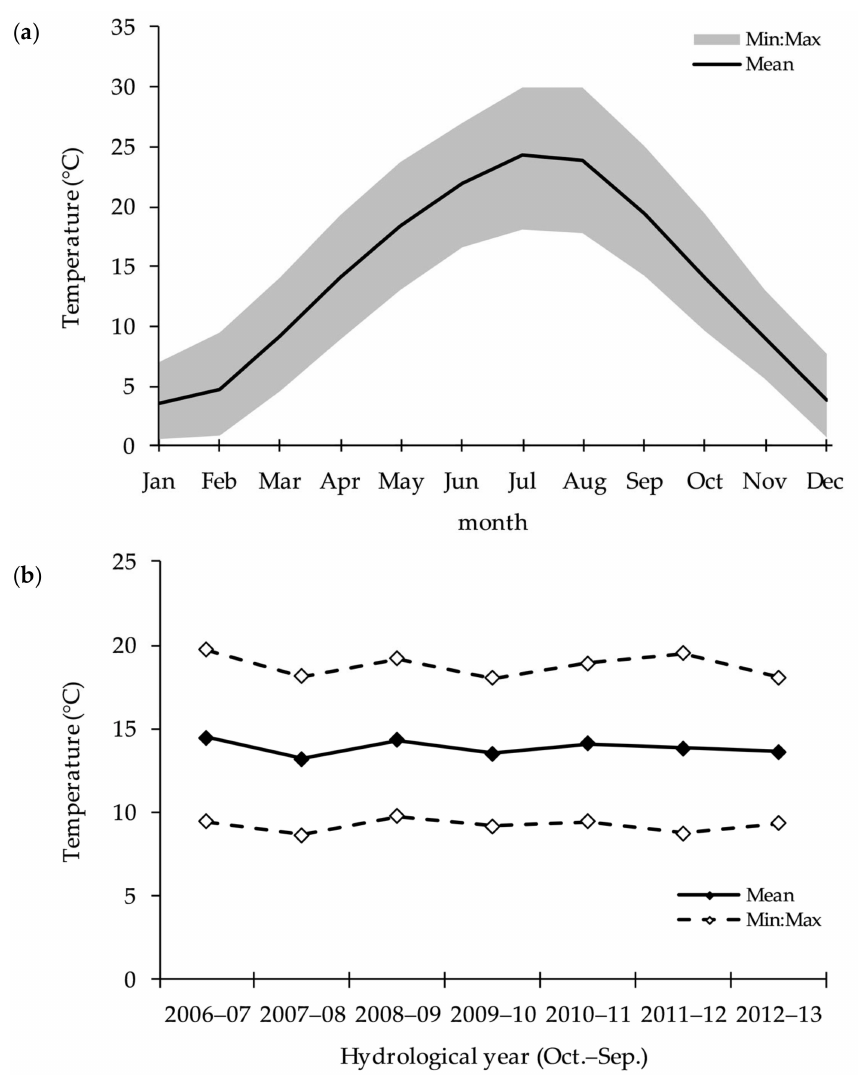
Figure 3. ( a ) Monthly air temperature at 2 m height (mean, minimum, and maximum temperatures are reported). ( b ) Annual air temperature at 2 m height (mean, minimum and maximum temperatures